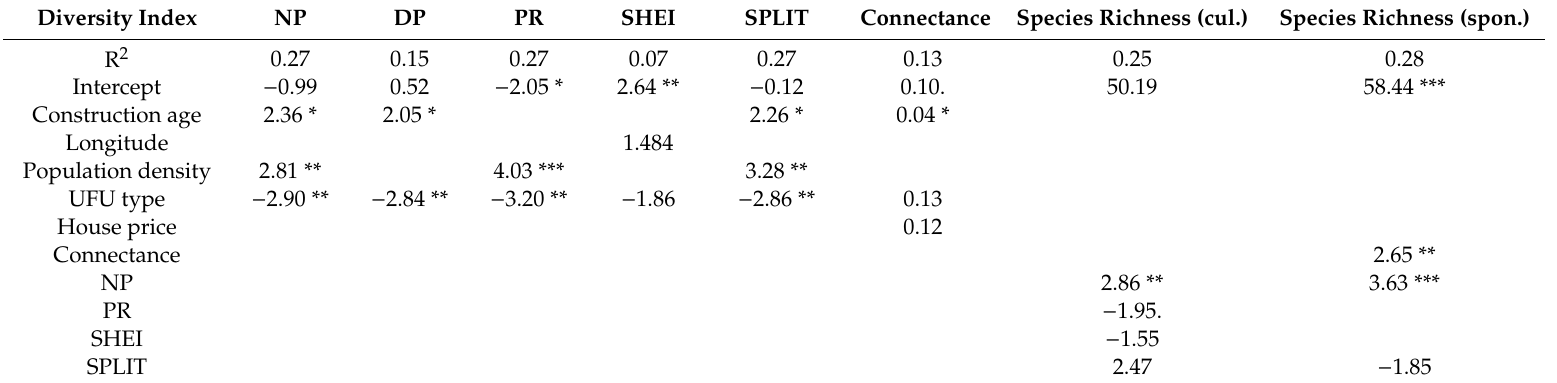
Table 6. Top models predicting species richness of spontaneous and cultivated species, and landscape pattern in Zhanjiang, Guangdong province, China. For each model, we reported the R-squared value (R 2 ), and for each predictor its estimated coe ffi